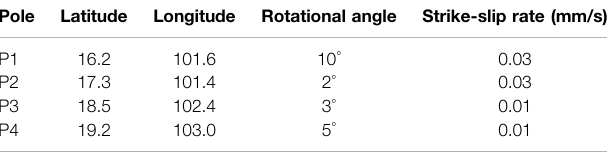
TABLE 1 | Pole of rotation.